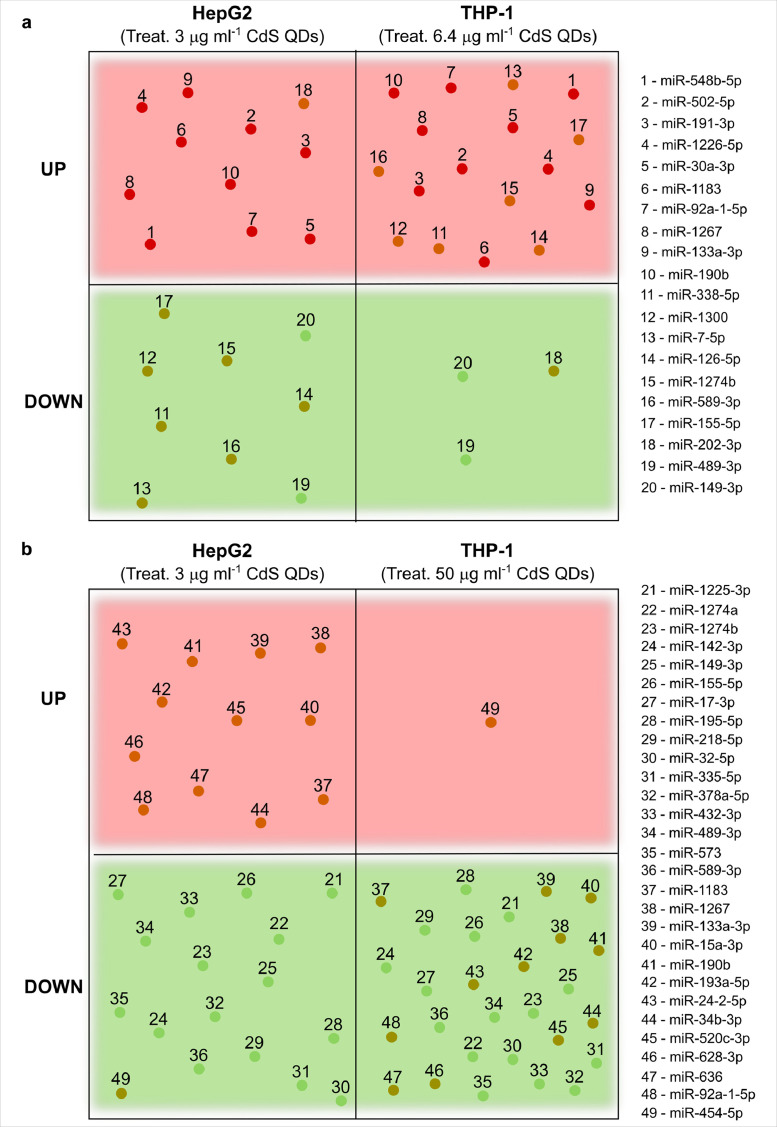
The common set of miRNAs responsive to CdS QDs stress in both cell types. The number in the boxes indicates the specific miRNAs listed in the border of the figure. The up-regulated miRNAs are in the red squares; those shared in the response of THP-1 and HepG2 cells are in red while those responding in a contrasting manner are in orange. The down-regulated miRNAs are in the green boxes; those shared in the response of THP-1 and HepG2 cells are in green while those responding in a contrasting manner are in dark green. a, Comparison between HepG2 cells and THP-1 cells exposed to the lower dose of Cd, 2.3 and 5 µg ml−1, as CdS QDs. b, Comparison between HepG2 cells and THP-1 cells exposed to 2.3 and 39 µg ml−1 Cd as CdS QDs, 3 and 50 µg ml−1, respectively.